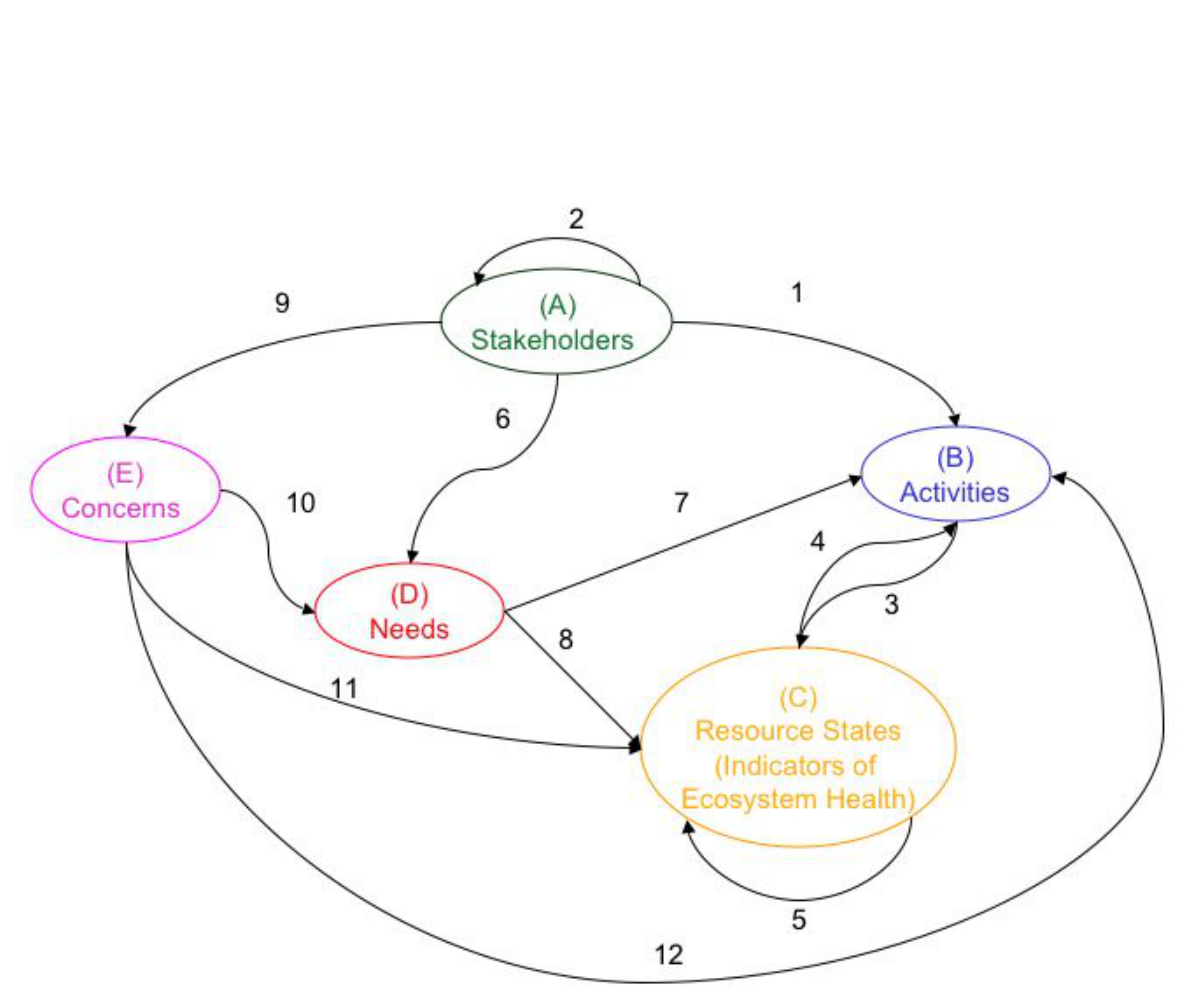
Fig. 4 . Conceptual Model of Ecosystem